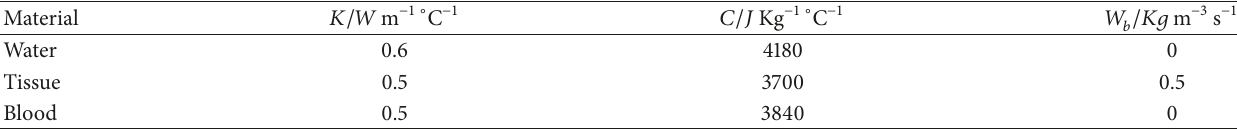
Table 2: Values of thermal parameters in this